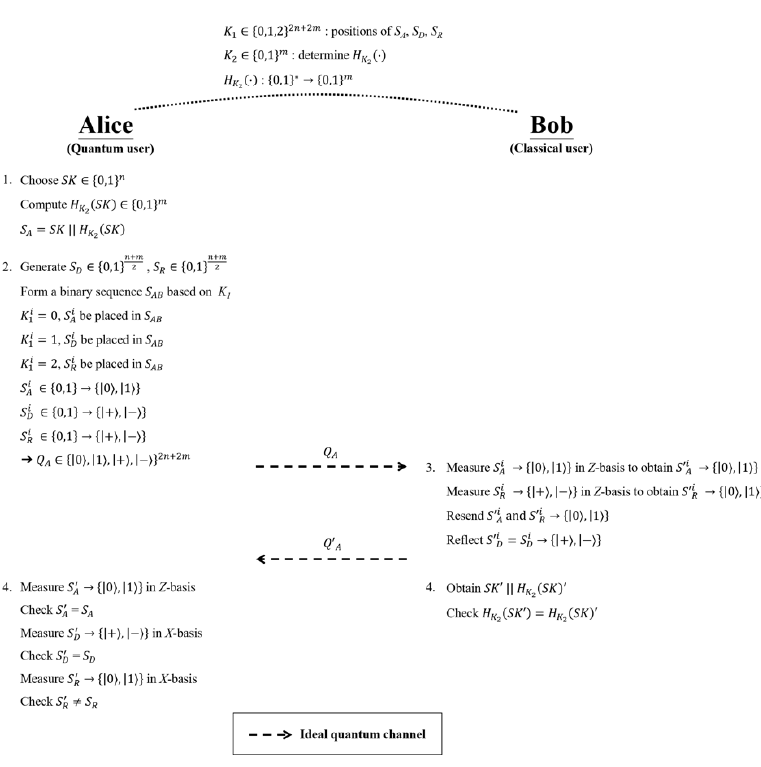
Figure 1. The proposed ASQKD